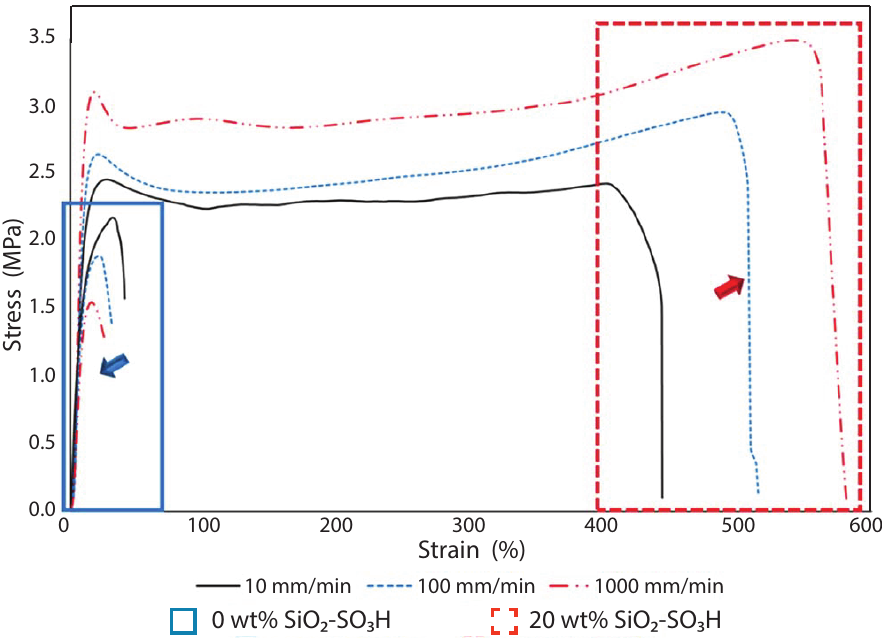
Figure 11. Stress–strain curves of polyurethanes (solid blue square) and the ionic PU nanocomposite containing 20 wt% of nanosilica (dash red square) at different strain rates: 10 mm/min (solid black line), 100 mm/min (dash blue line) and 1000 mm/min (dash dot red line). Reprinted with permission from Odent et al.